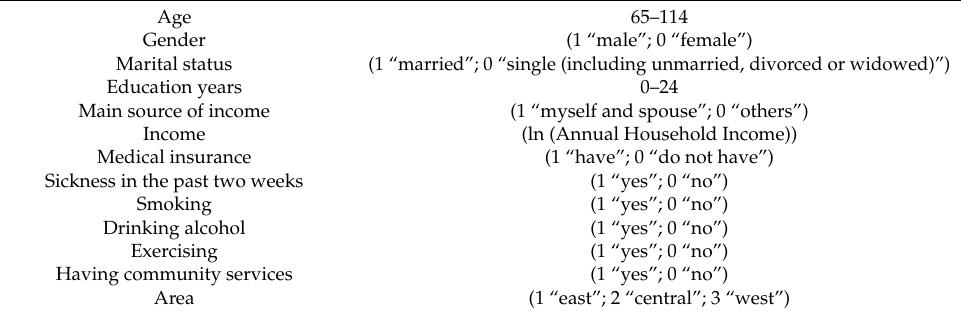
Table 1. Control variables.